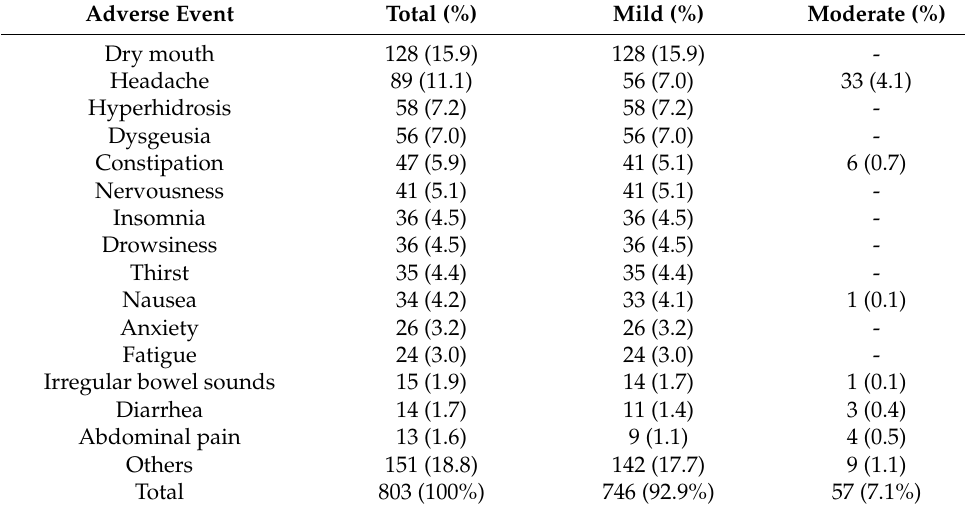
Table 3. Main adverse events reported by patients with obesity who received 30 mg phentermine for 6